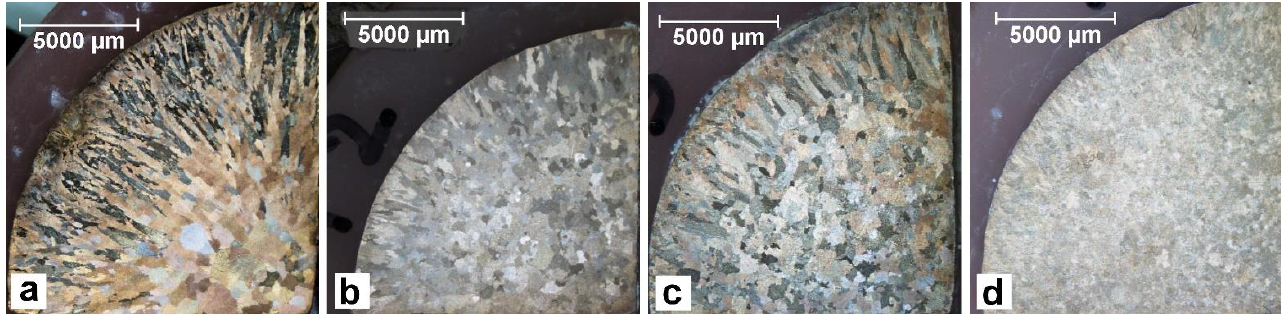
Figure 2. Microstructure of the alloy, 0.67x, metal mould: ( a ) CuSn8; ( b ) CuSn8Ti2; ( c ) CuSn8Ni3; ( d ) CuSn8NiTi2 [32].